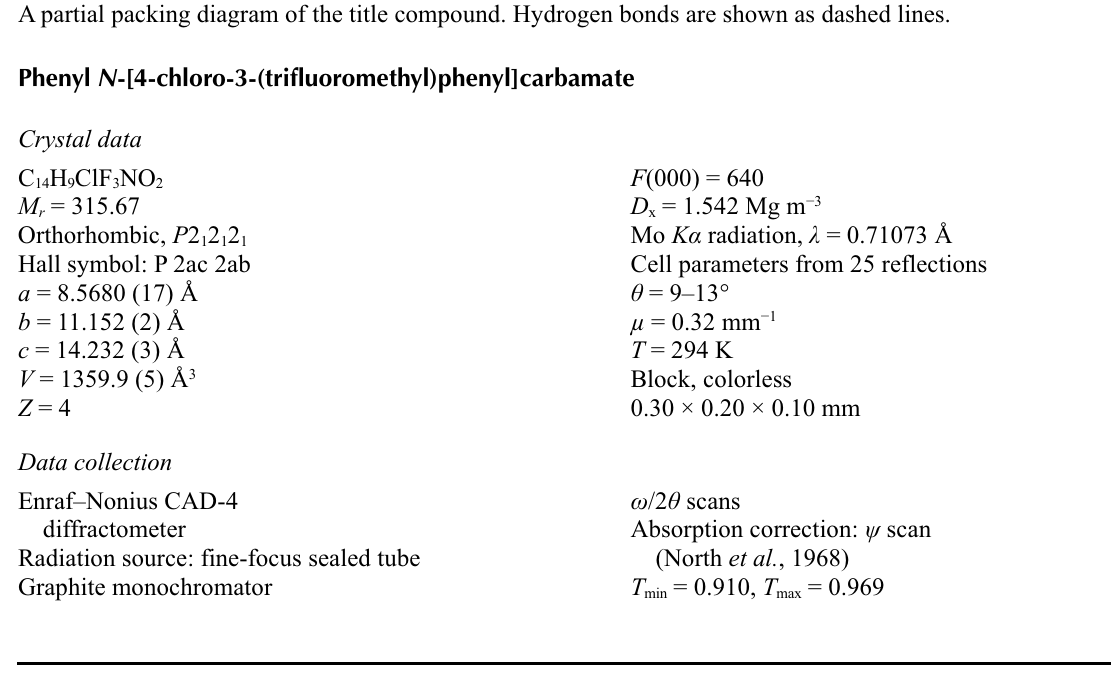
A partial packing diagram of the title compound. Hydrogen bonds are shown as dashed